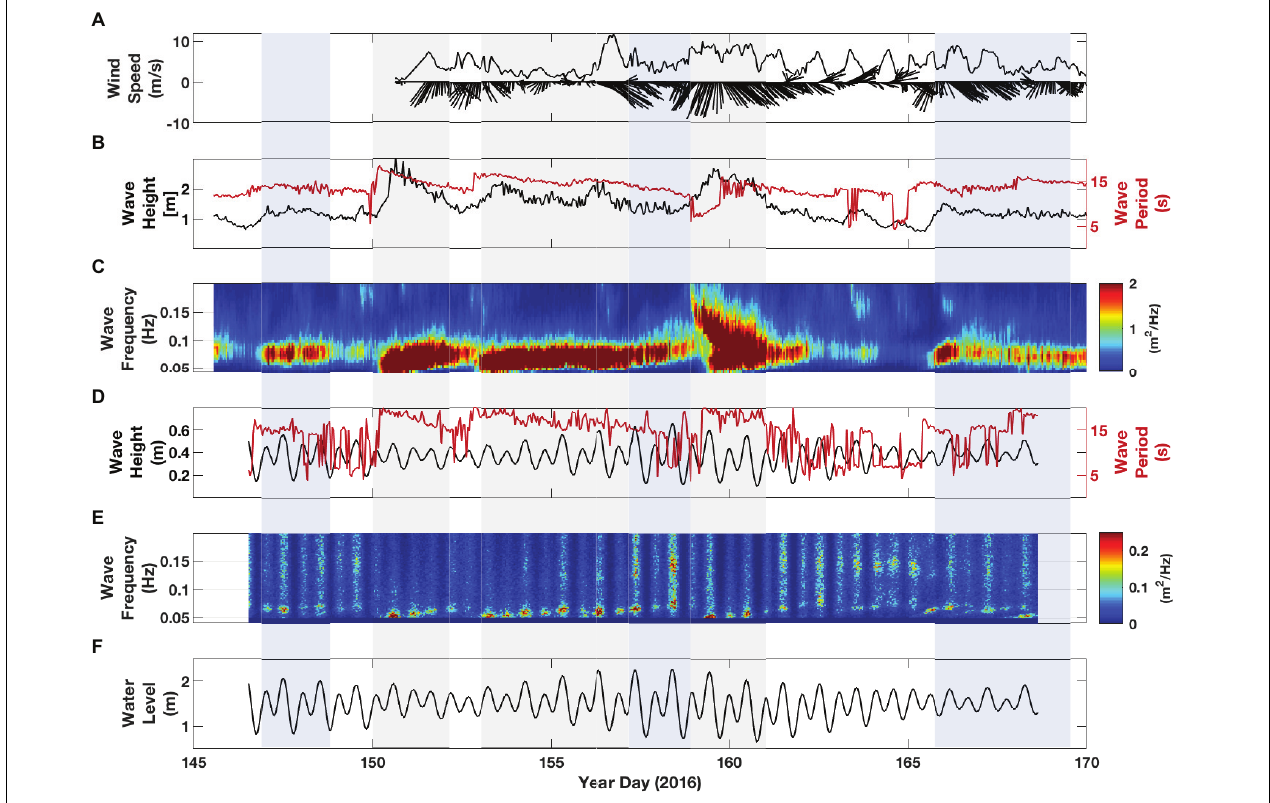
FIGURE 2 | Meteorologic and oceanographic forcing during the measurement period. (A) Wind speed and 3-h average wind vectors measured at the shoreline. (B) Offshore significant wave height and peak wave period. (C) Offshore wave spectral energy density at station M0. (D) Wave height and period near the reef crest at station TR1. (E) Wave spectral density near the reef crest. (F) Water level on the reef. The time frames shaded in gray represent “swell events” where offshore wave heights were greater than 1.5 m and wave periods were longer than 13 s. The areas shaded in blue represent time frames where there were consistent offshore waves heights greater than 1 m with periods greater than 12